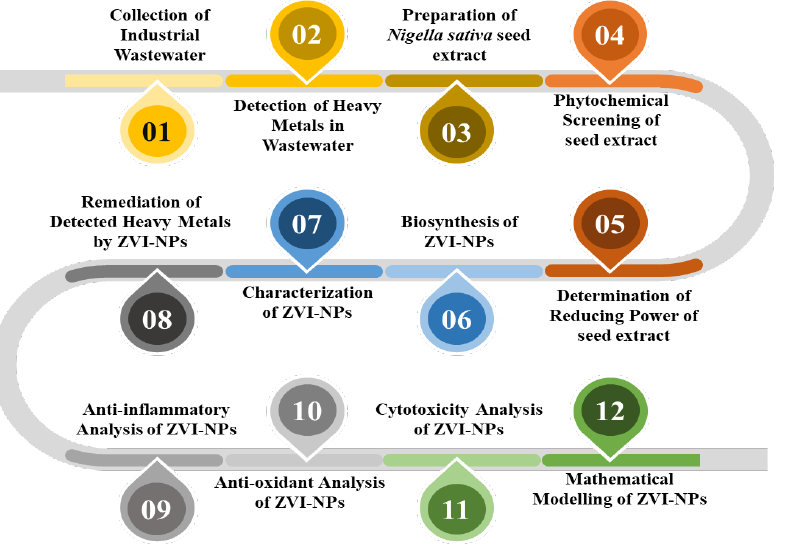
Figure 16 . A schematic illustration of showing the overview of the methodology used to synthesize ZVI - NPs and its